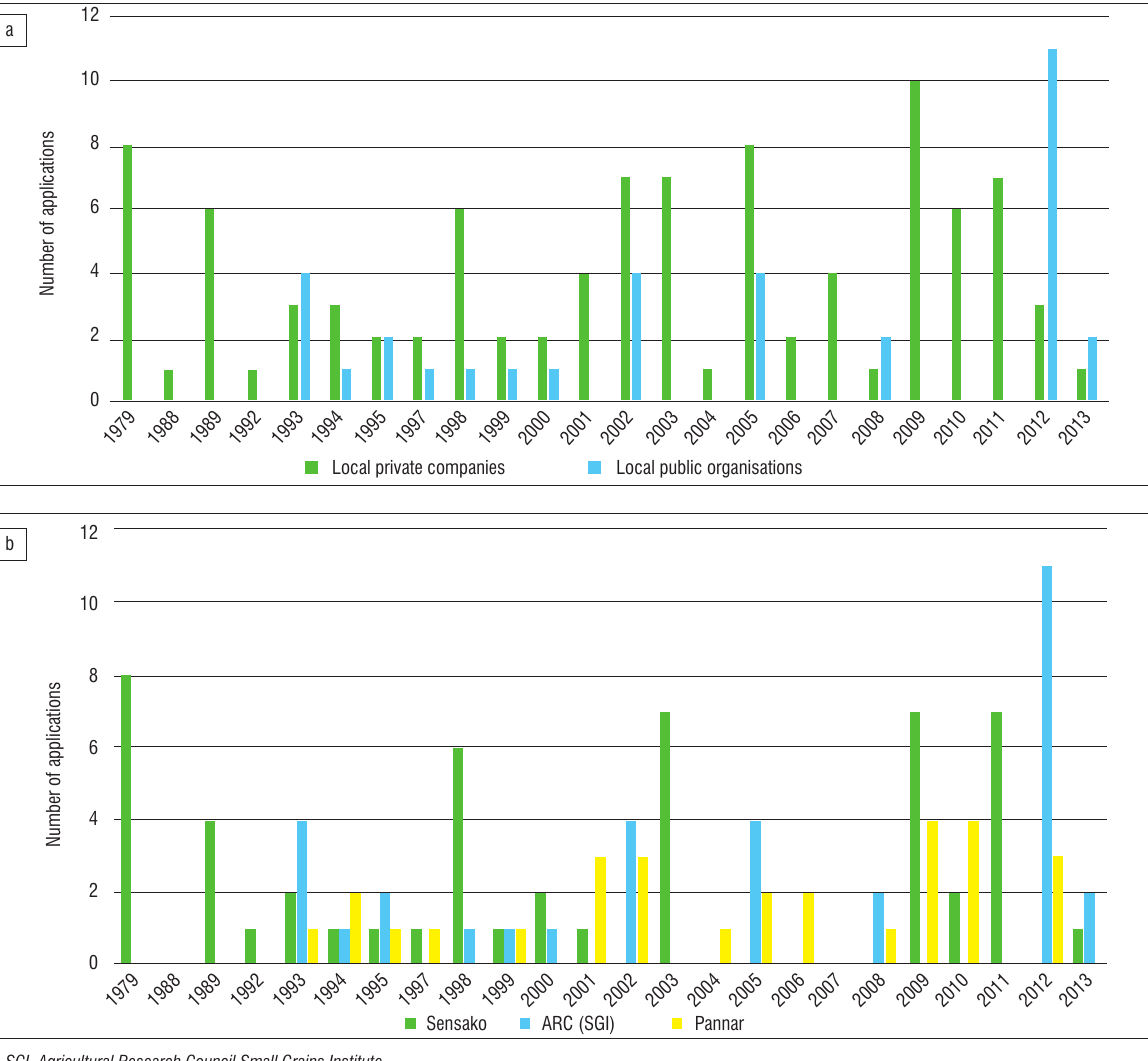
Figure 4: Applications for plant breeders’ rights for (a) wheat by private vs public organisations and for (b) wheat made by the main role players from 1979 to 2013, compiled from data in South African Plant Variety